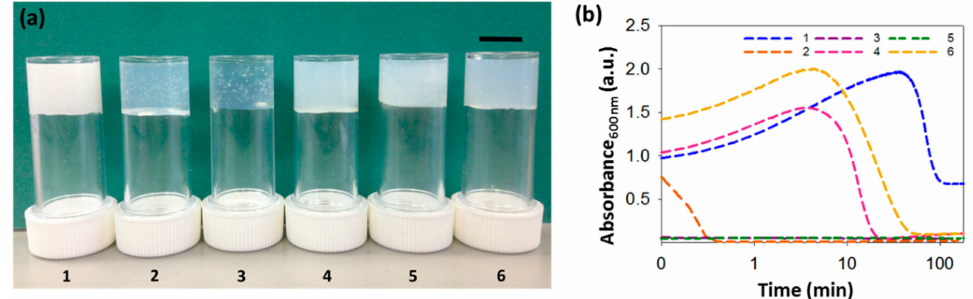
Figure 2. Gels and turbidity changes during gelation. ( a ) Photographs of gels formed from gelators 1 – 6. The scale bar represents 1 cm. ( b ) Change in turbidity during gelation at 600 nm for gels 1 – 6 , showing di ff erent kinetics patterns. Logarithmic axis is used, due to time–scale similarities in the rate of assembly for some gels. All gels at a concentration of 5 mg mL − 1 and a ratio of DMSO to water of